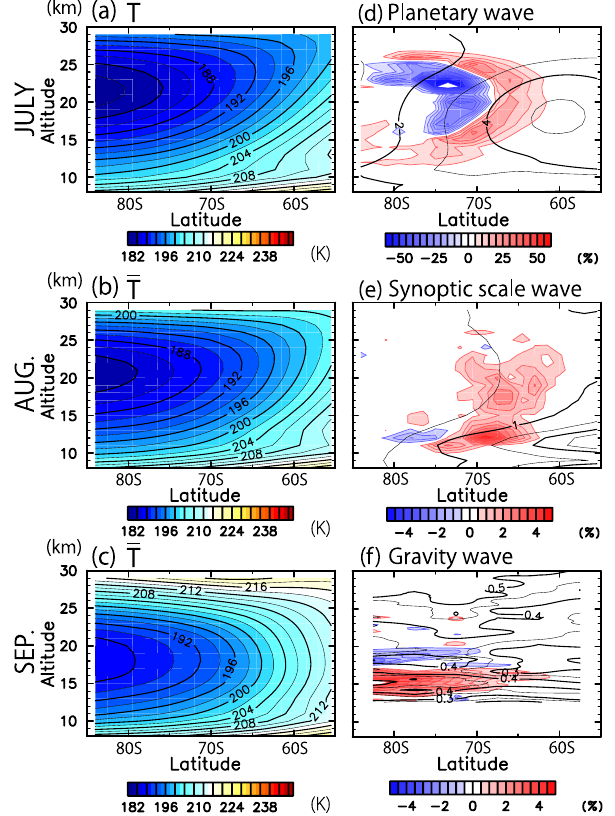
Fig. 12. (a–c) Latitude-altitude sections of zonal-mean and monthly-mean temperature in July through September. Contour in- tervals are 2K. (d–f) Latitude-altitude sections of zonal-mean and monthly-mean difference of PSC frequency 1F between with and without (d) planetary waves in July, (e) synoptic-scale waves in Au- gust and (f) gravity waves in September. Positive values mean an increase in PSC frequency. Black contours indicate temperature standard deviation due to the respective waves. Contour intervals are 1K for (d) , 0.5K for (e) and 0.05K for (f)